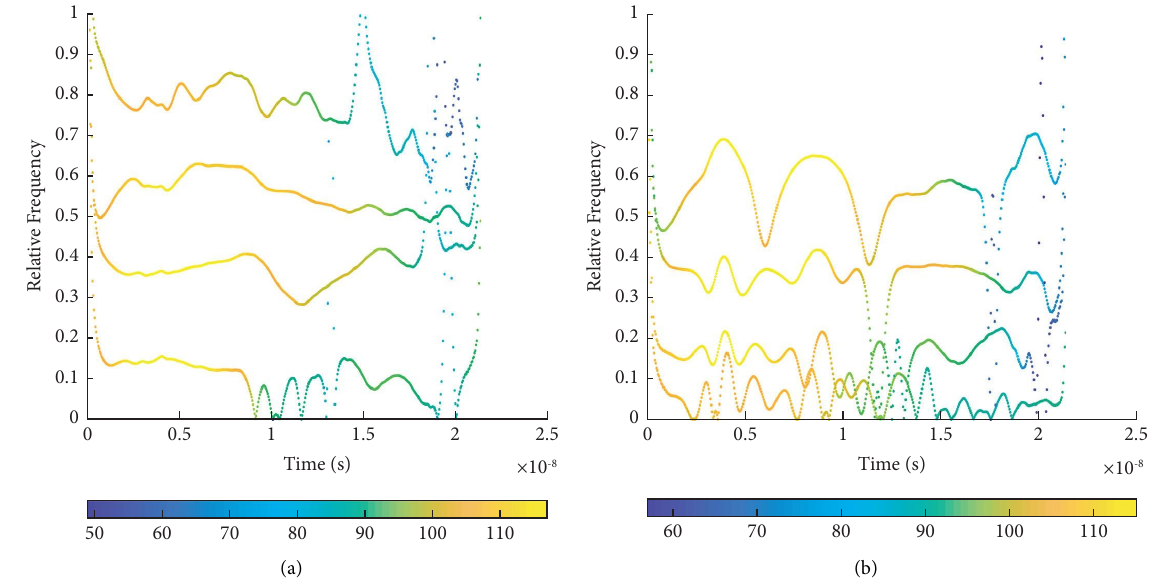
Figure 7: Hilbert spectrum of the modes from optimized VMD GPR of dry ballast (a). Wet ballast